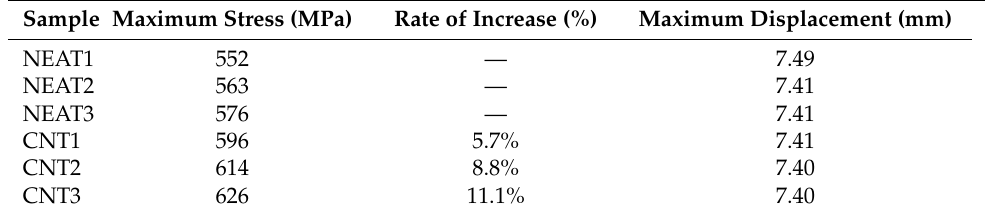
Table 2. The maximum axial tension load and displacements of